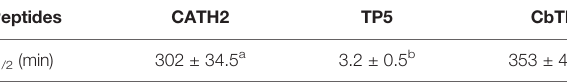
IL-1 b in the serum of mice were measured. As shown in Figure 7A , CTX treatment resulted in signi fi cant reductions in TNF- a , IL-6, and IL-1 b levels. The administration of CbTP caused a marked increase in all these cytokine levels in the serum of mice.